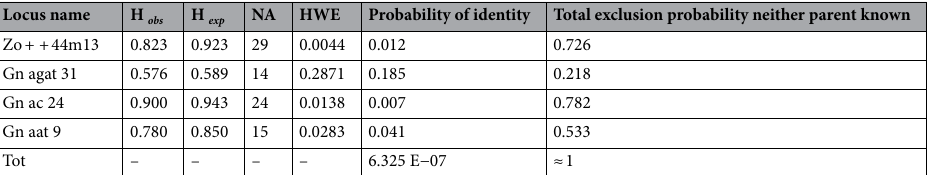
Table 3. Summary of genetic diversity at four microsatellite loci selected for parentage analysis in Gobius niger . The table shows locus name, observed (H obs ) and expected (H exp ) heterozygosity, number of alleles (NA), Hardy–Weinberg Equilibrium probability (HWE), probability of identity, for each locus and for all loci, calculated with GENALEX and exclusion probabilities, associated with each locus and for all loci, calculated with